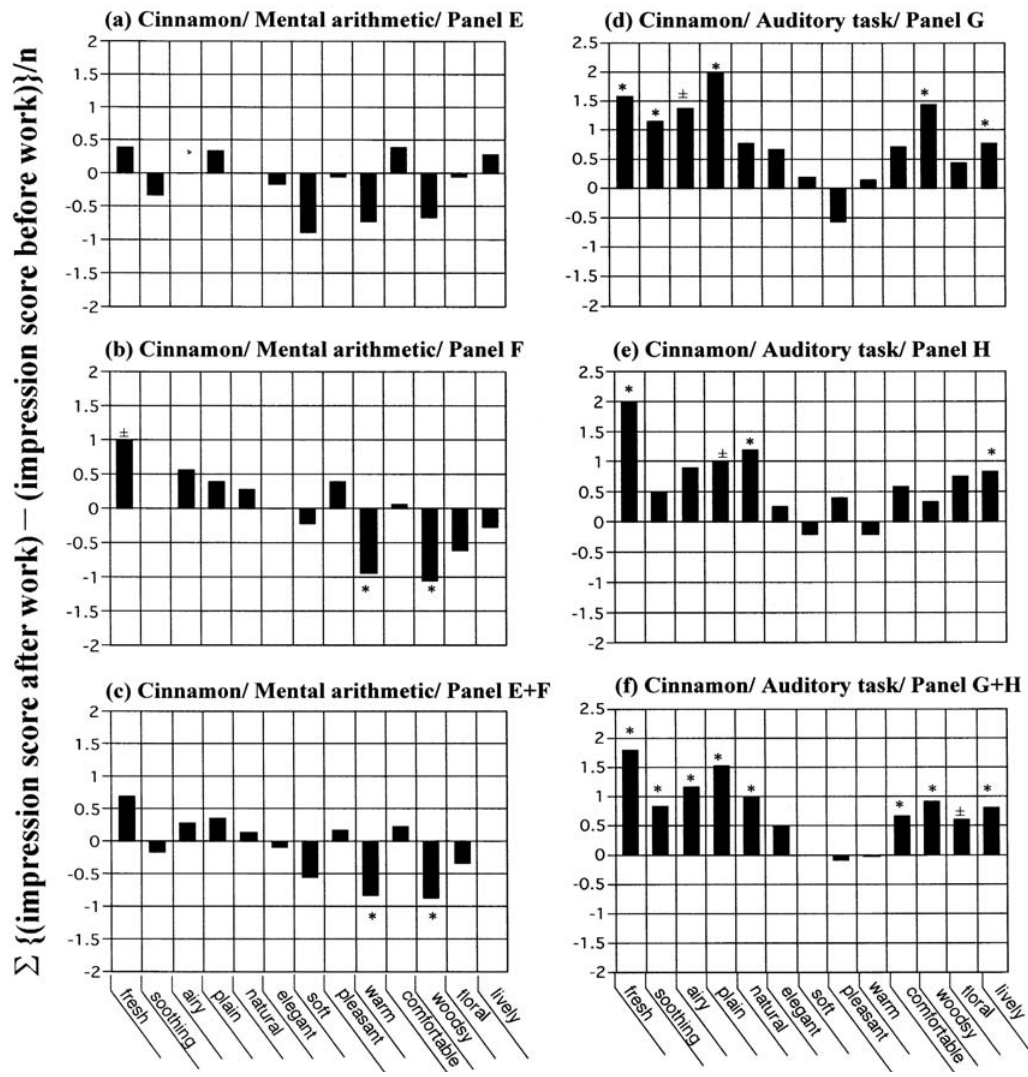
Figure 4. A duplication of sensory profiling conducted for cinnamon each versus mental arithmetic and the auditory task. All other conditions were identical with those in Figure 3. The number of subjects was ( a ) 18 for Panel E, ( b ) 18 for Panel F and ( c ) 36 for Panel E + F as with cinnamon versus mental arithmetic; ( d ) 21 for Panel G, ( e ) 20 for Panel H and ( f ) 41 for Panel G + H as with cinnamon versus the auditory task. The total significance scores were calculated as 0.0 for ( a ), 2.5 for ( b ), 2.0 for ( c ), 5.5 for ( d ), 3.5 for ( e ) and 8.5 for ( f